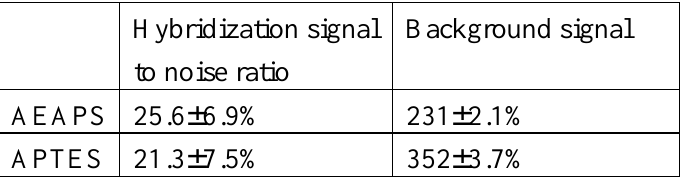
Table 1. Comparison of AEAPS and